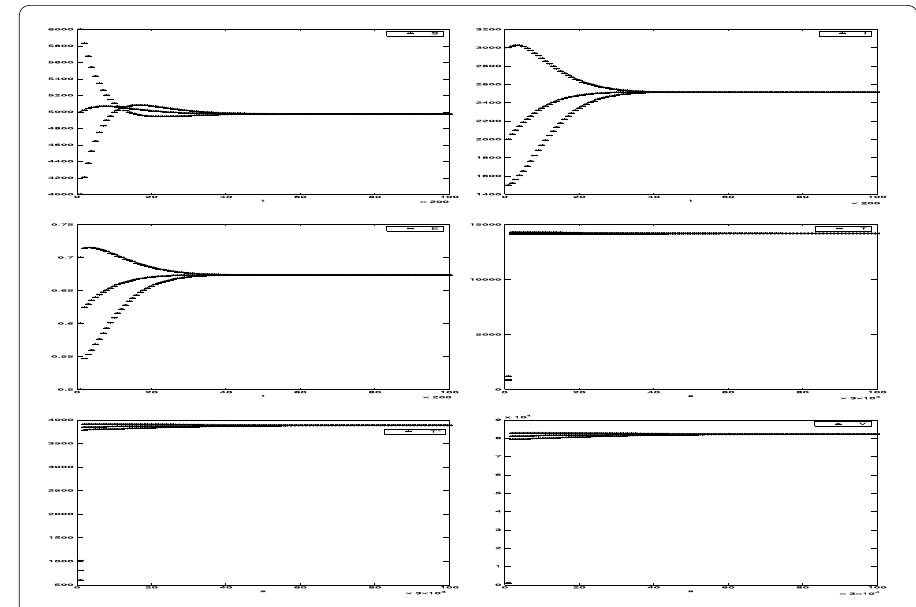
Figure 1 The trajectories of solutions ( S ( t ), I ( t ), E ( t ), T ( s ), T ∗ ( s ), V ( s )) with initial values ( S (0), I (0), E (0), T (0), T ∗ (0), V (0)) = (4000,1500,0.5,800,800,800),(5000,2000,0.7,1210,1010,1000) and